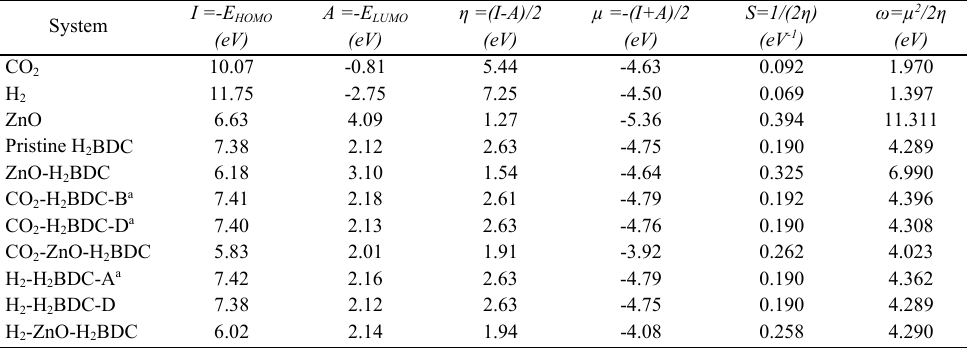
Table 2: Chemical potential (µ), hardness (η), softness (S) and electrophilicity (ω) of CO CO